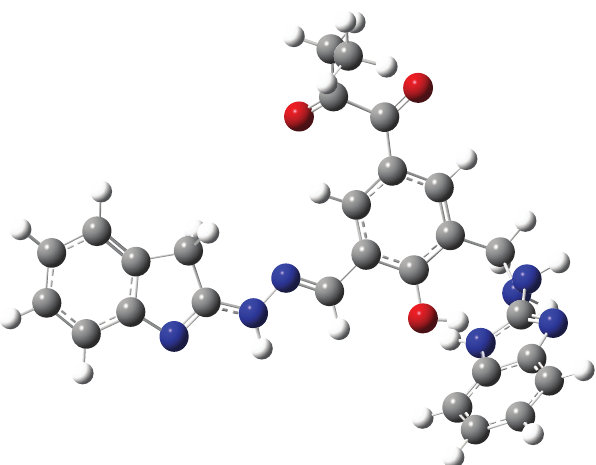
Figure 8: Most stable structure of Ligand 19 in the gas phase optimized at M06/6-31g(d) level in Gaussian 09.